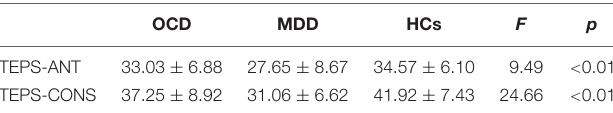
TABLE 2 | Comparisons of consummatory and anticipatory pleasure among OCD patients, MDD patients, and healthy controls